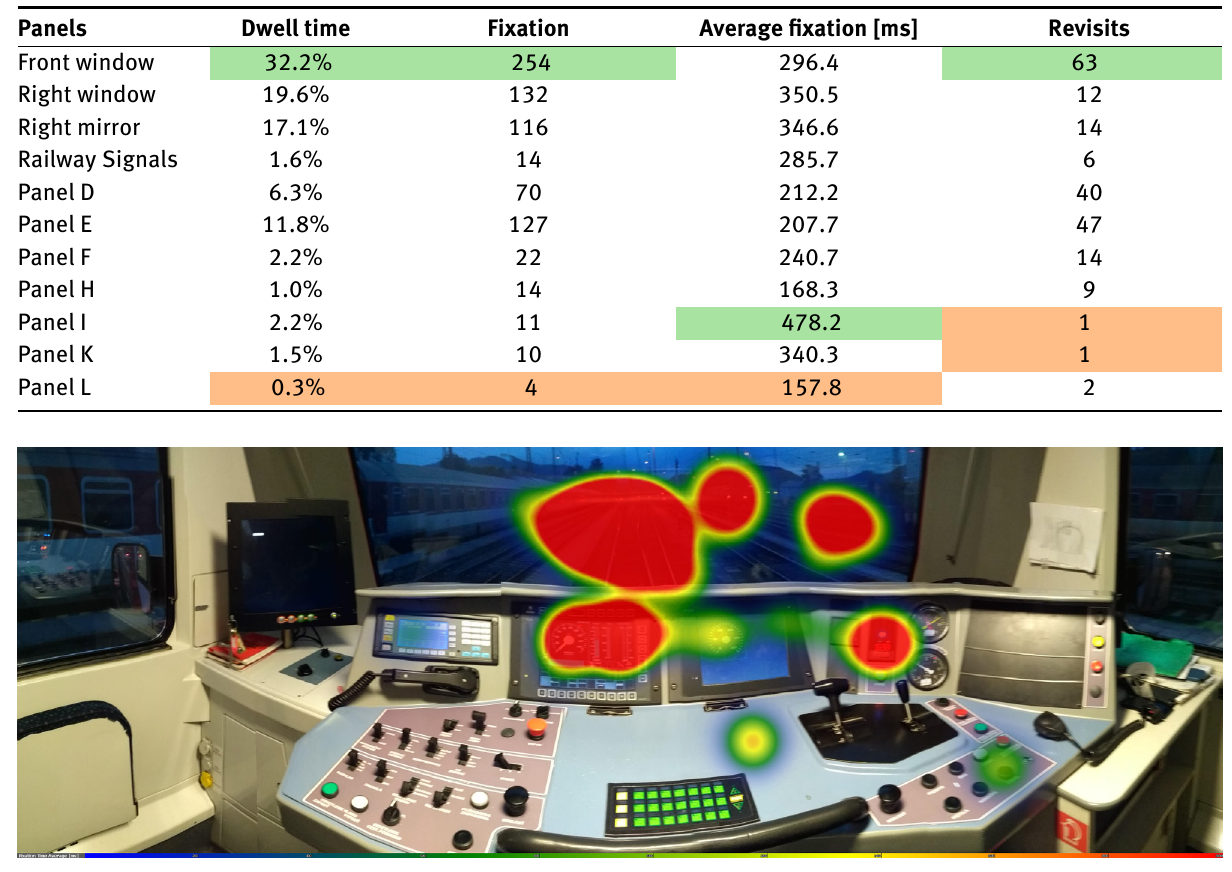
the most revisits have a front window part (63), and the least revisits have a panel I (1) and K